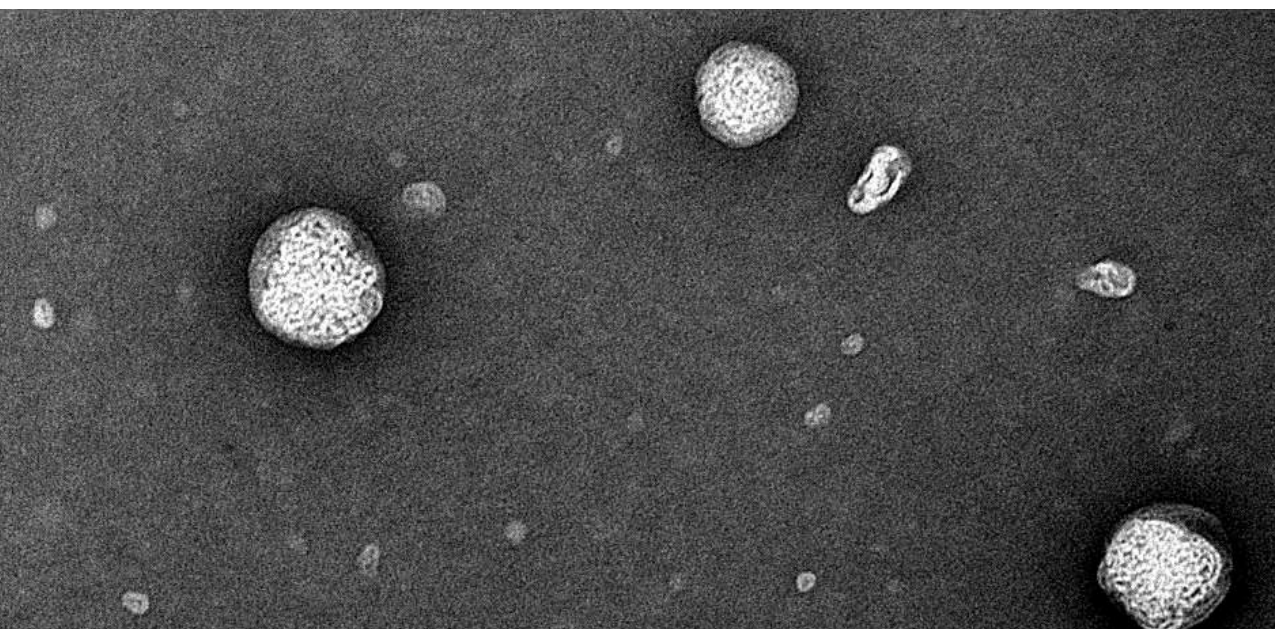
Figure 15. TEM of the picked optimized NLC formula.